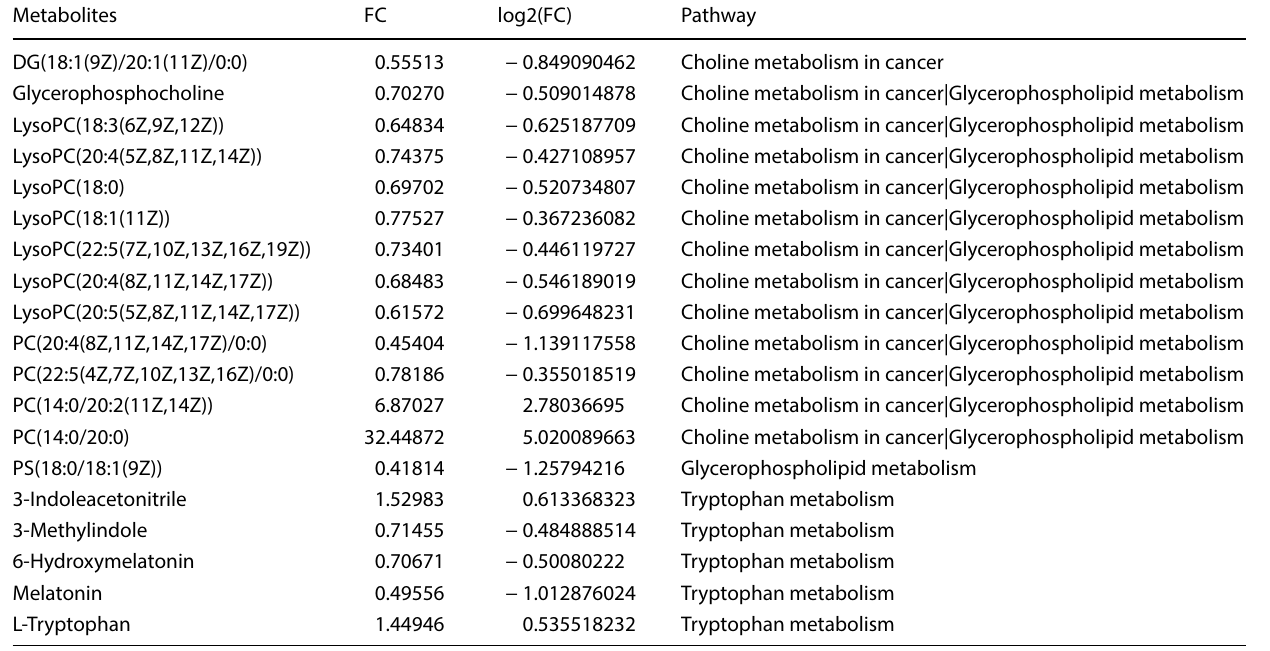
Table 1 The differential metabolites in choline metabolism, tryptophan metabolism and glycerophospholipid metabolism between SBI- 115-treated-group and DMSO-treated group Metabolites FC log2(FC)